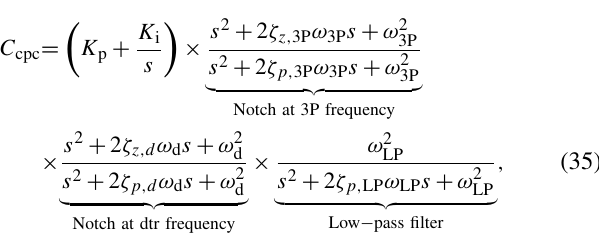
controller of the CPC loop is given